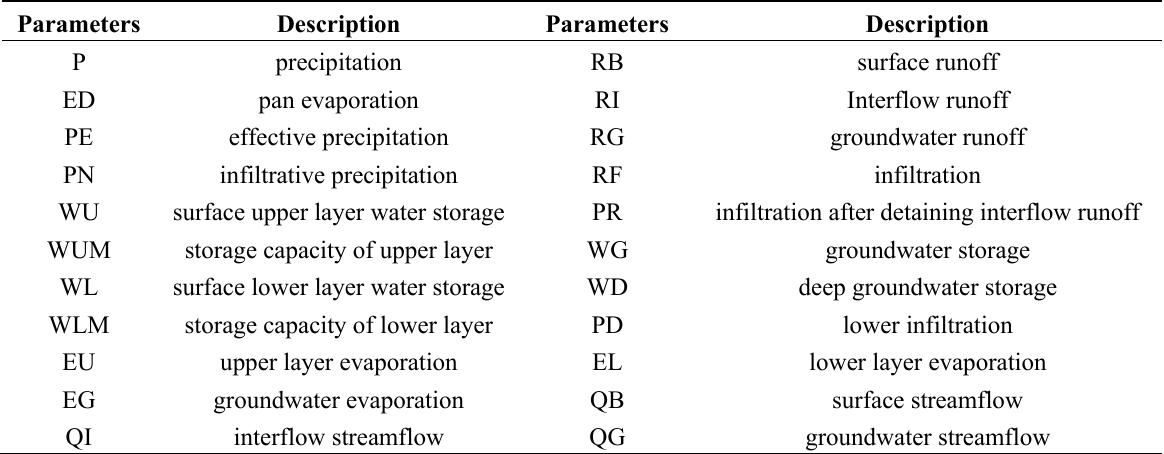
Figure 2. Flowchart of the DHF hydrological model. Table 1. Parameters description of the DHF hydrological model.